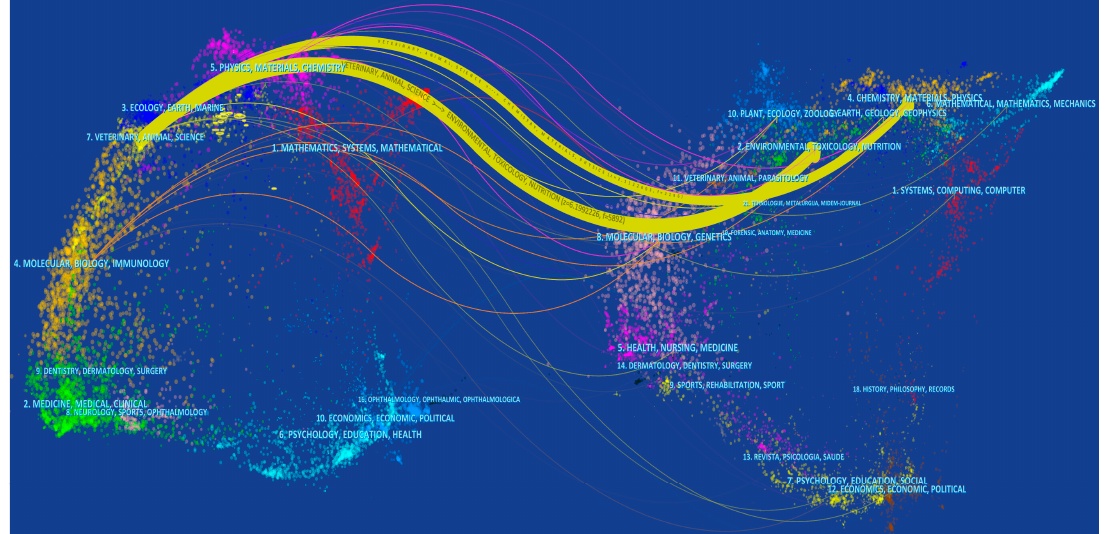
Figure 2. Double-map overlay for tannery wastewater research. Analysis of tannery wastewater using a double-map overlay is illustrated. On the left side of figure, the most widely cited research literature on tannery wastewater covers the fields of veterinary medicine, zoology and science. Environmental science, toxicology and nutrition are all included in the study of tannery wastewater on the right side.